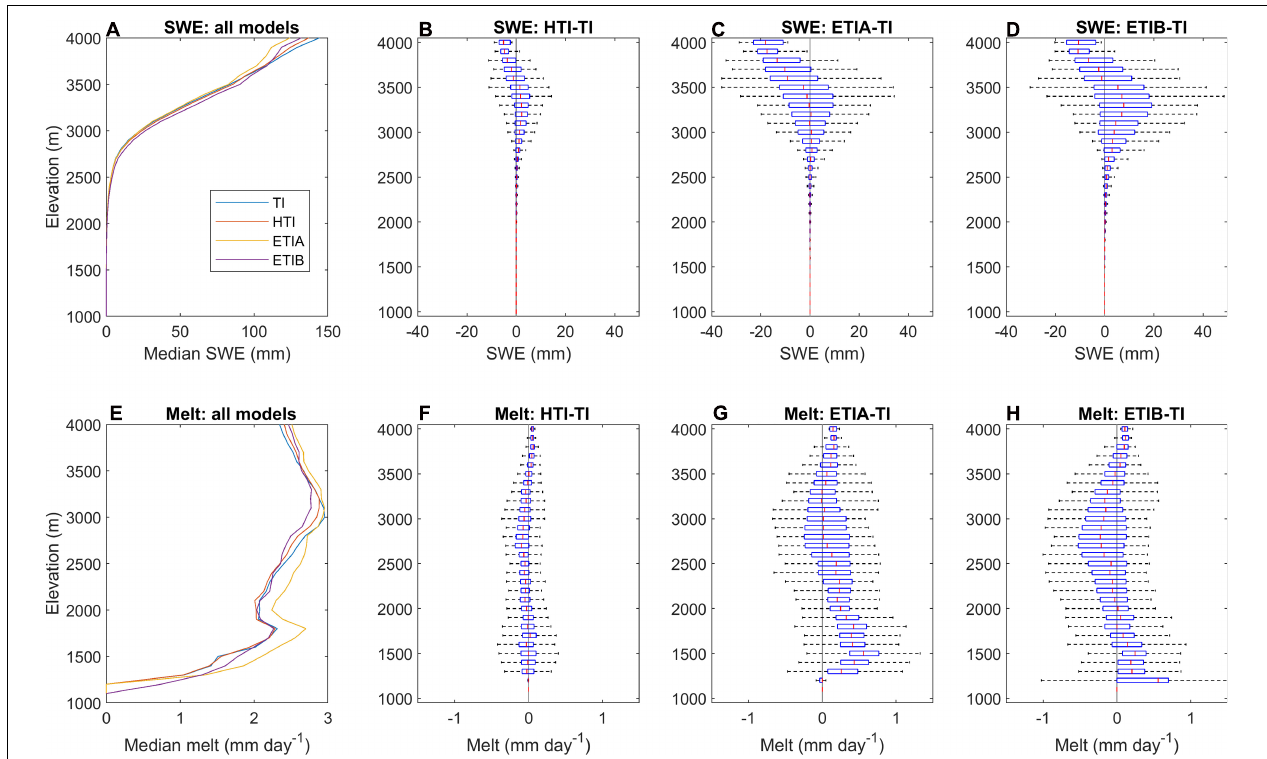
FIGURE 9 | Mean simulated SWE and melt by elevation for days with snow. (A) Median SWE for all models. (B–D) SWE differences between radiative and reference TI model. (E) Median melt rate for all models. (F–H) Melt differences between radiative and TI